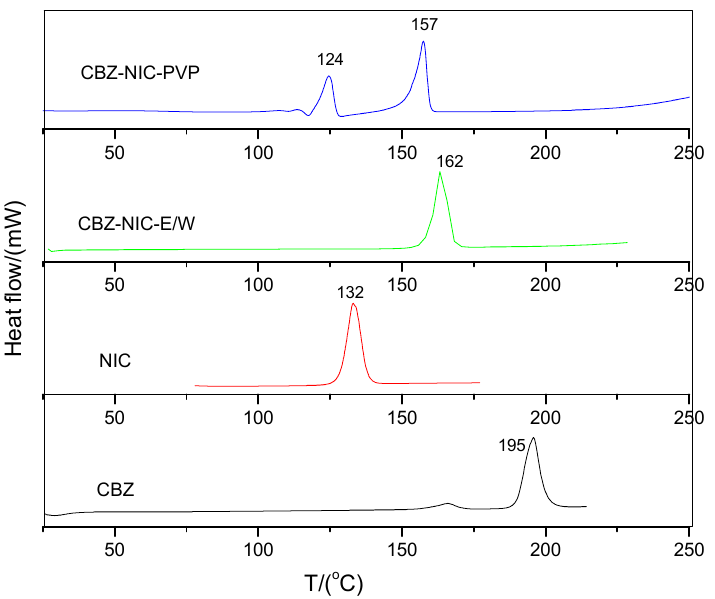
Figure 4. Differential Scanning Calorimetry (DSC) curves of CBZ, NIC, CBZ-NIC-E/W, and CBZ-NIC-PVP.